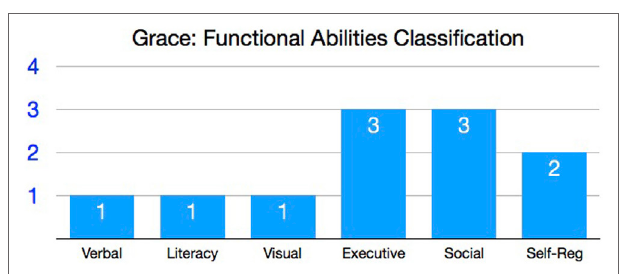
FigUre 4 | “Grace”: classification of functional ability